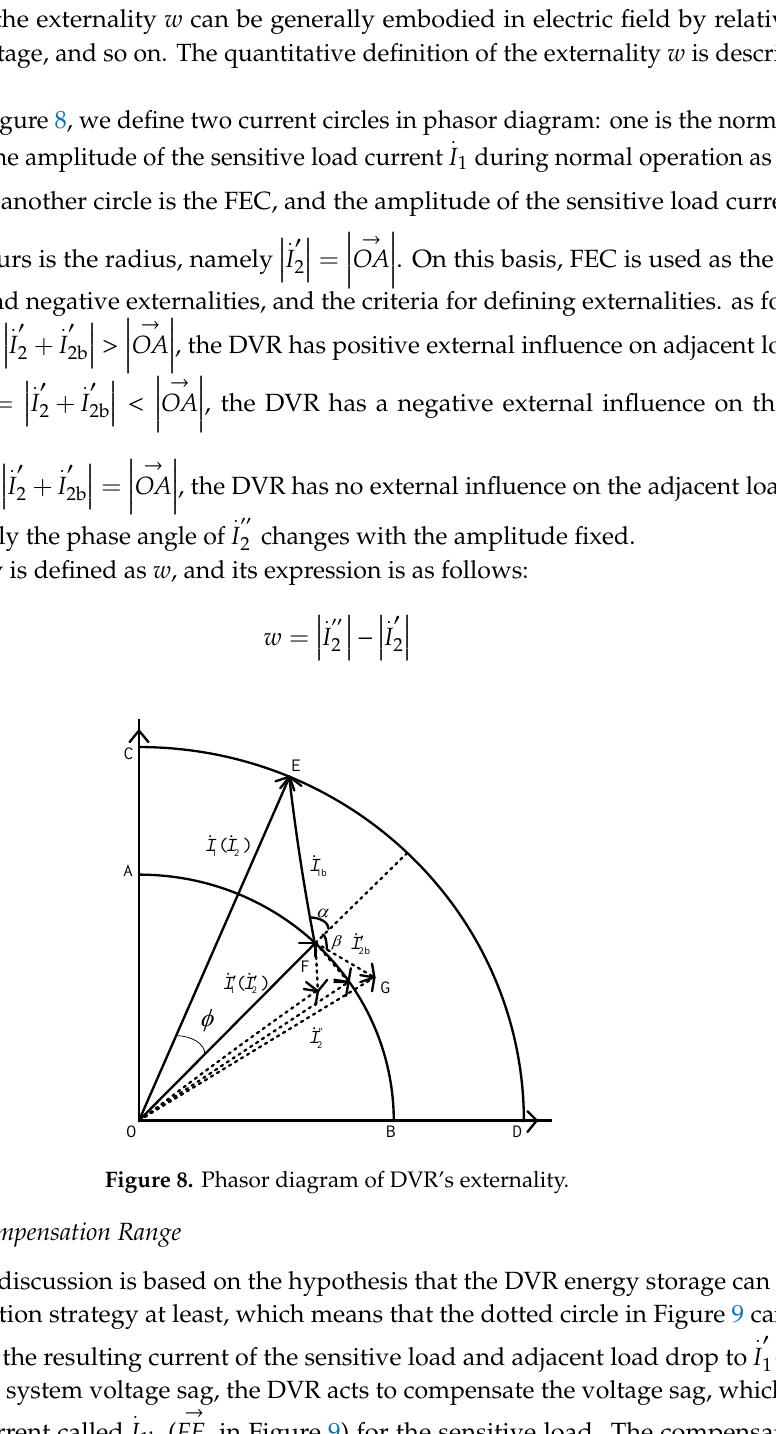
O Figure 9. Phasor diagram of the external compensation range. In phasor diagram analysis of the traditional DVR compensation strategy, in order to represent the DVR compensation capability limit, the concept of DVR compensation voltage limit circle (CVLC) is often cited [28]. Correspondingly, the concept of DVR compensation current limit circle (CCLC) is created in this paper. The point F, as the phasor end of sensitive load current